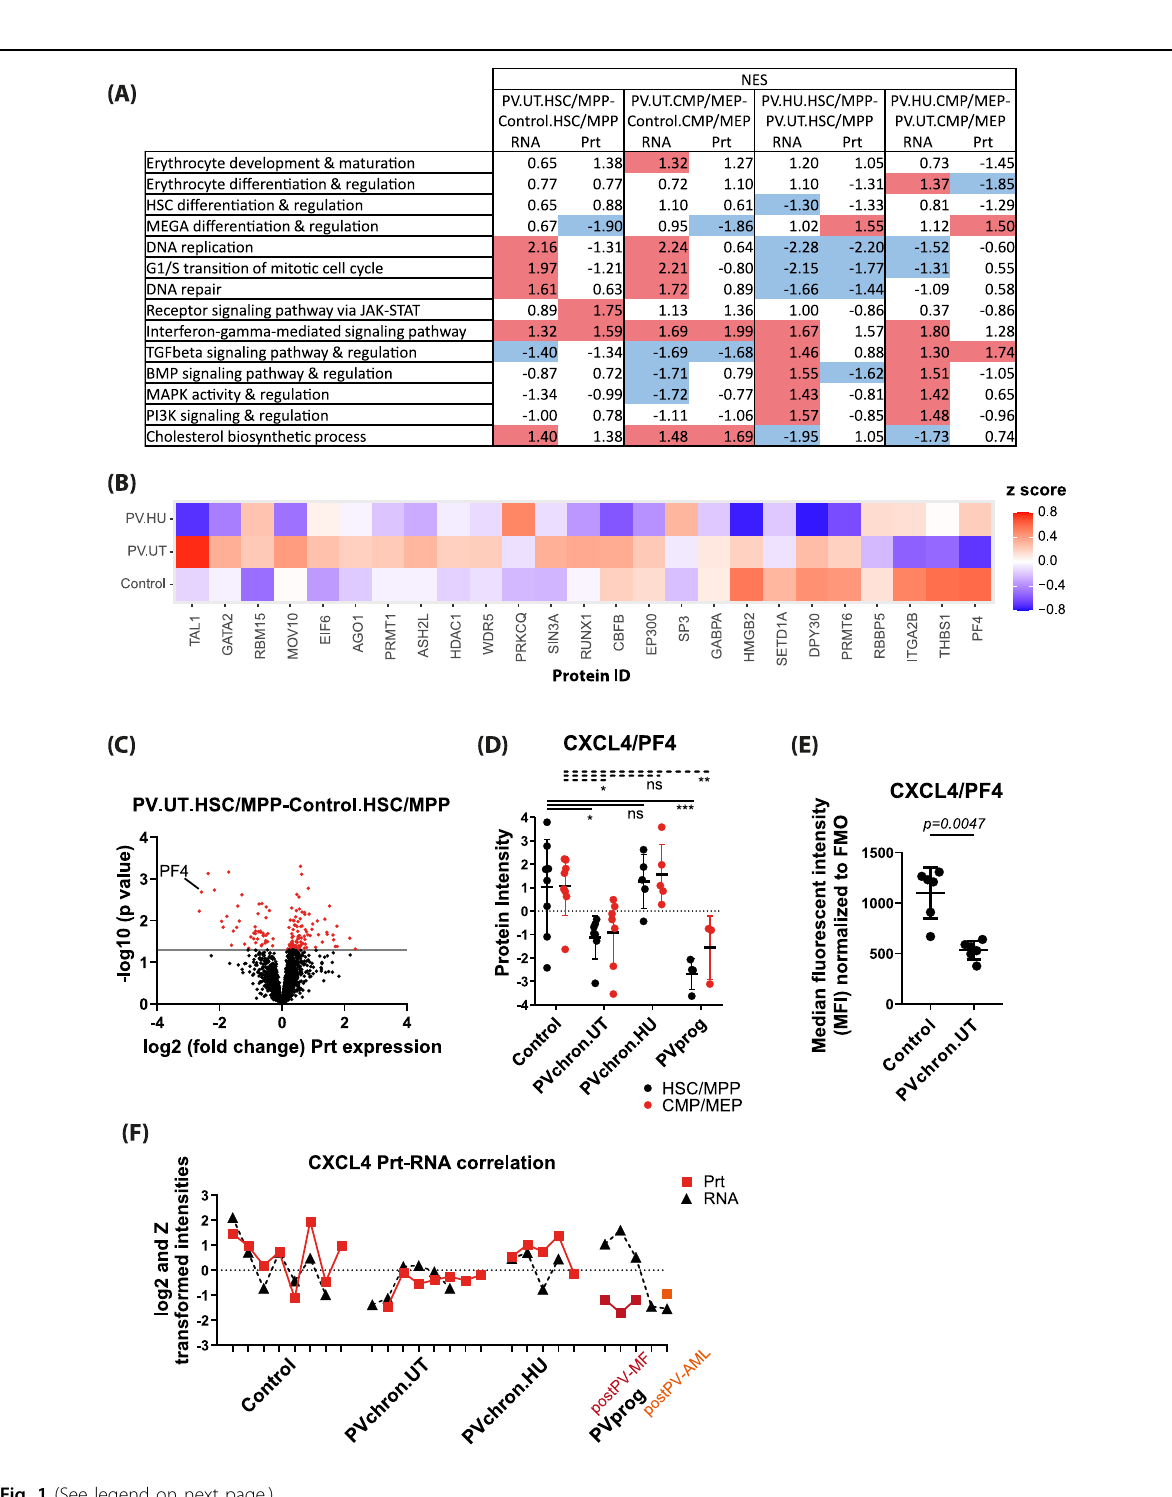
Fig. 1 (See legend on next